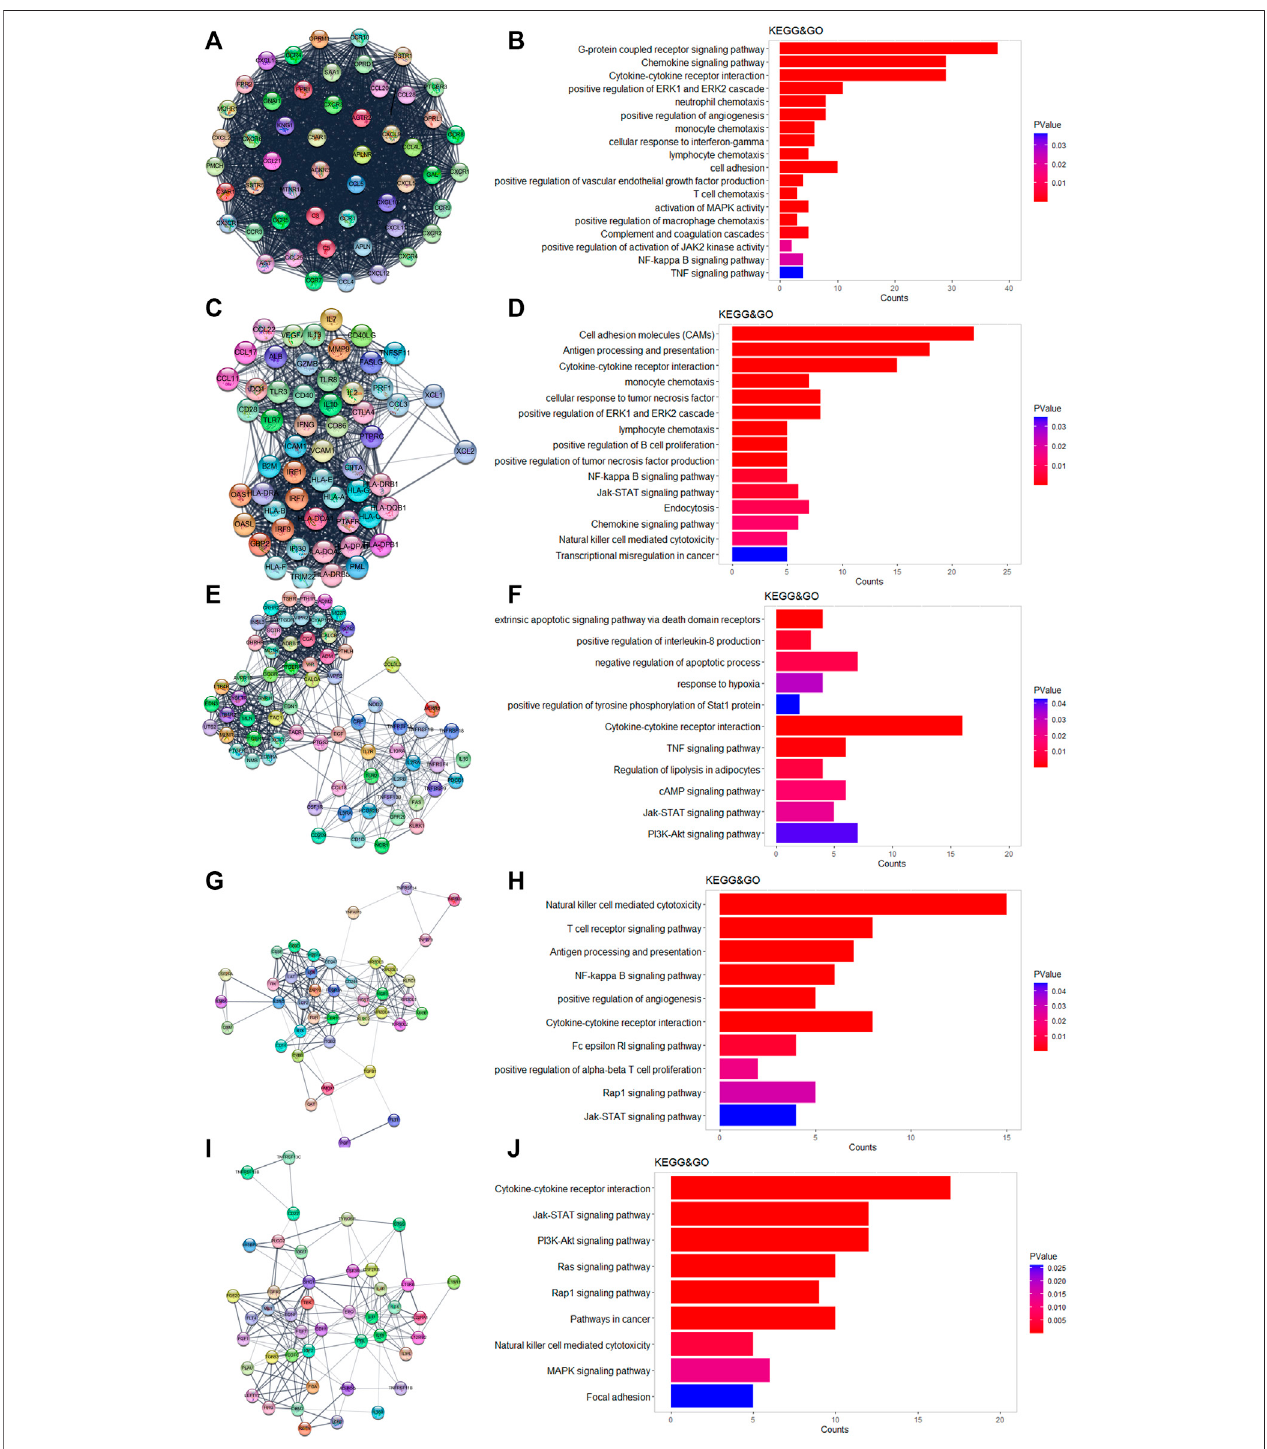
FIGURE 3 | Results of MCODE in DEGs. (A,C,E,H,I) Top fi ve modules calculated by MCODE plugin. (B,D,F,H,J) GO and KEGG enrichment results of the fi ve modules.